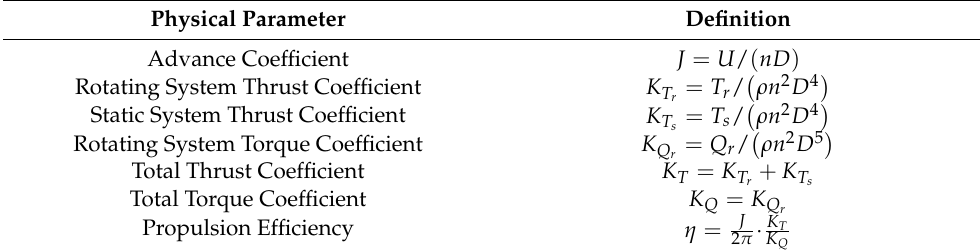
Table 4. Dimensionless expression of related physical parameters.